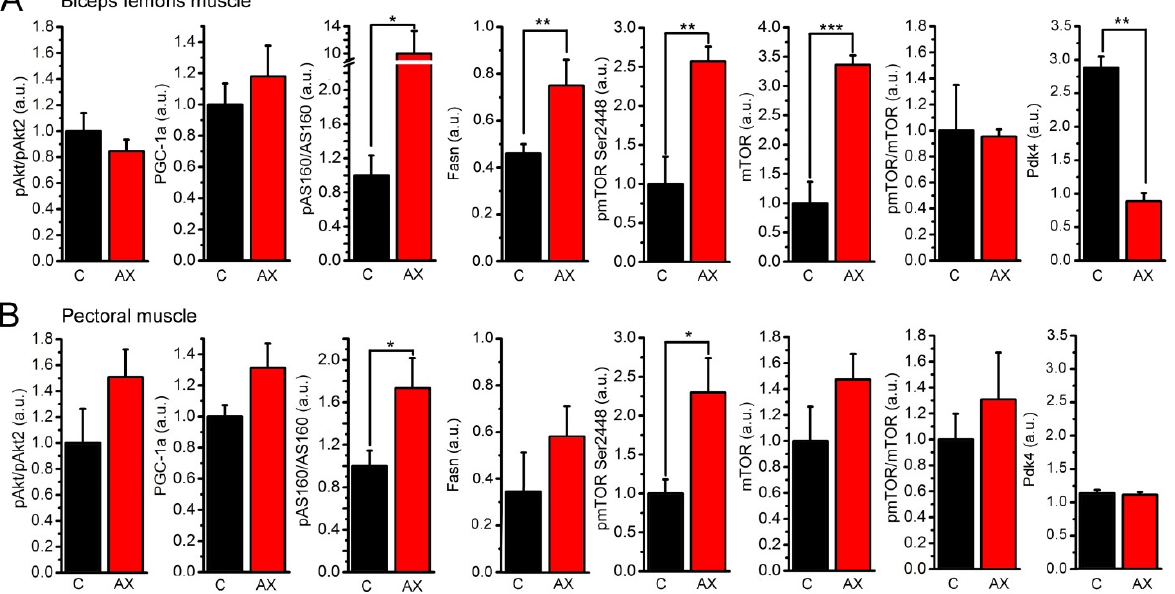
Figure 2. Effects of astaxanthin feeding on the levels of signaling proteins in biceps femoris and pectoral muscles. ( A ) Statistical analysis of changes in signaling protein expression of the biceps femoris muscle; ( B ) statistical analysis of changes in signaling protein expression of the pectoral muscles. Black columns (C): control, red columns (AX): astaxanthin feeding. Quantification of the results is reported as average ± SEM ( n = 3–5); * p < 0.05, ** p < 0.01, *** p < 0.001.